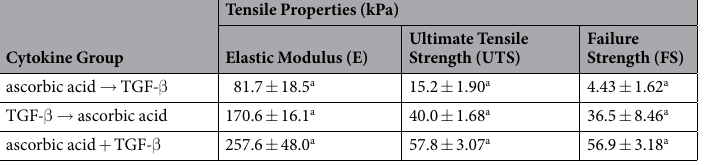
Table 1. Tensile properties of adventitia rings with different cytokine stimulation regimens. a Denotes statistical significance between all groups (p <